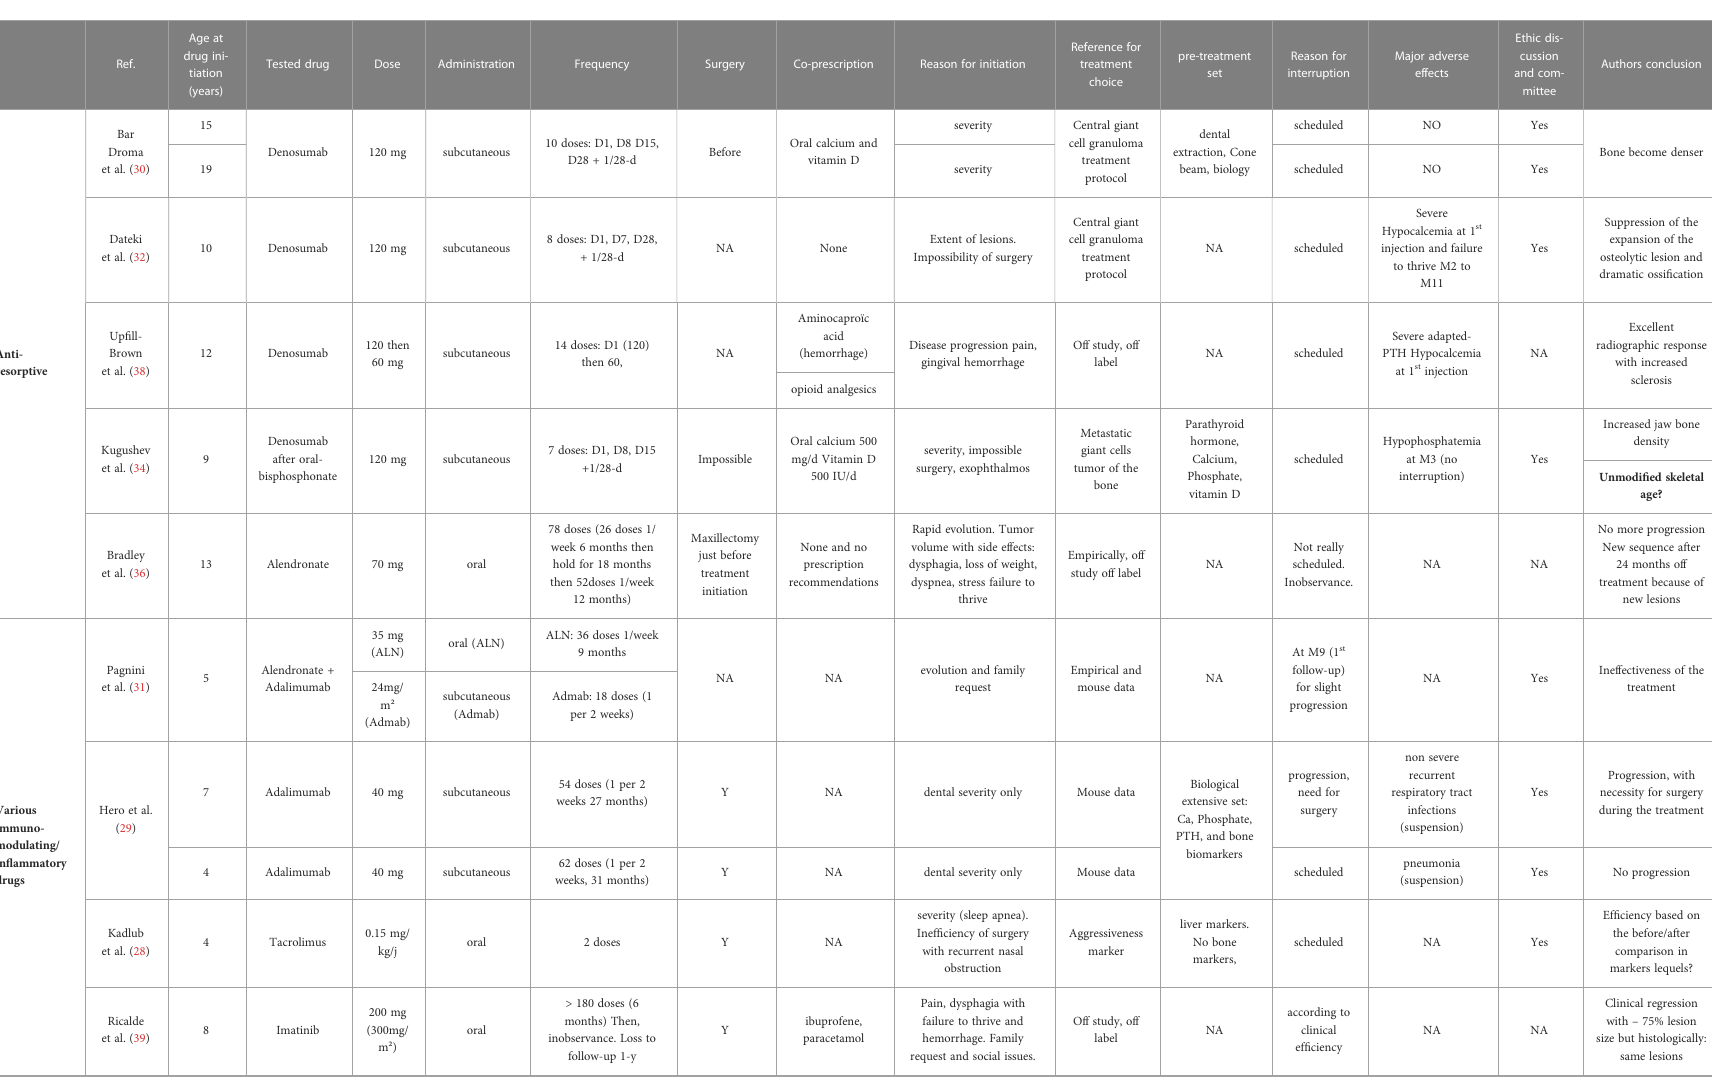
TABLE 4 Outcomes on drug ef fi cacy.